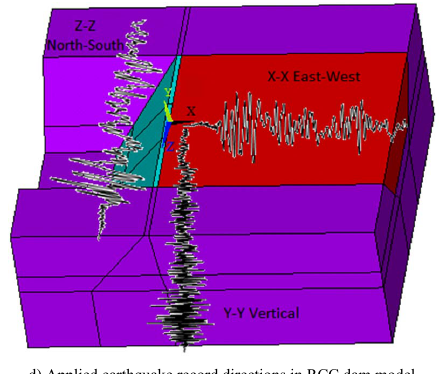
Fig. 12. 1999 Düzce earthquake records. Fig. 12. 1999 D¨uzce earthquake